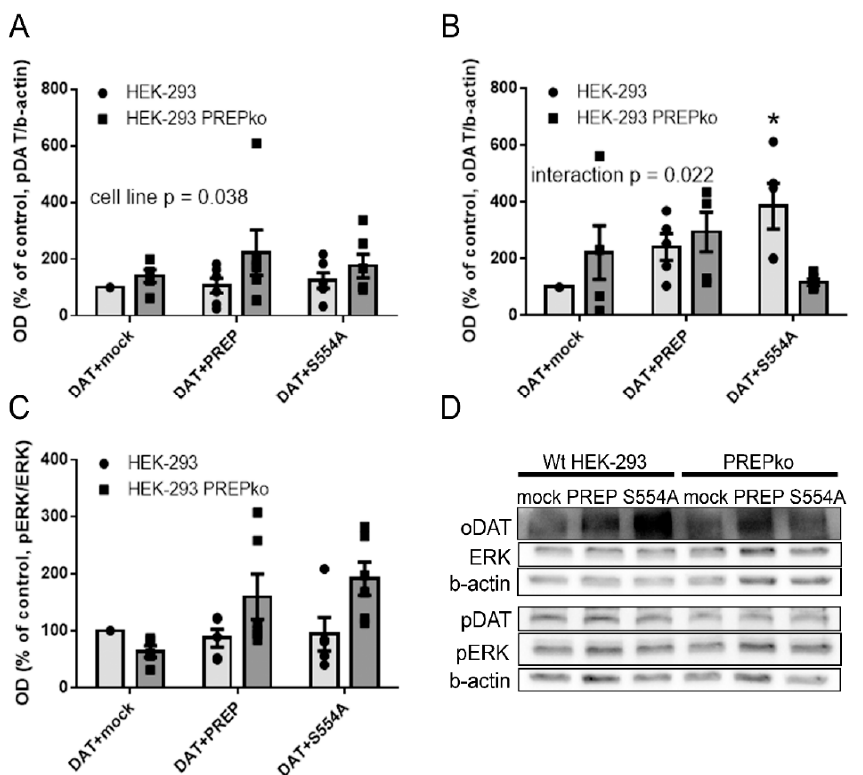
Figure 1. Prolyl oligopeptidase (PREP) regulates phosphorylation and oligomerization of dopamine transporter (DAT), and phosphorylation of extracellular signal-regulated kinase (ERK). Oligomeric DAT (oDAT), phosphorylated DAT (pDAT), ERK, and phosphorylated (pERK) were measured by Western blot (WB) in Wt HEK-293 and stable PREPko HEK-293 cells transfected with DAT and mock, DAT and PREP, or DAT and inactive PREP (S554A-PREP). Optical-density values were normalized to the loading control ( β -actin) optical density. Representative WB figures for ( A – C ) are presented in panel ( D ). Data were collected from six independent WBs that were done with samples from six independent cell culture preparations. Bars represent mean ± SEM., * p = 0.041 one-way ANOVA, Tukey ´ s post-hoc test. Other p -values are from two-way